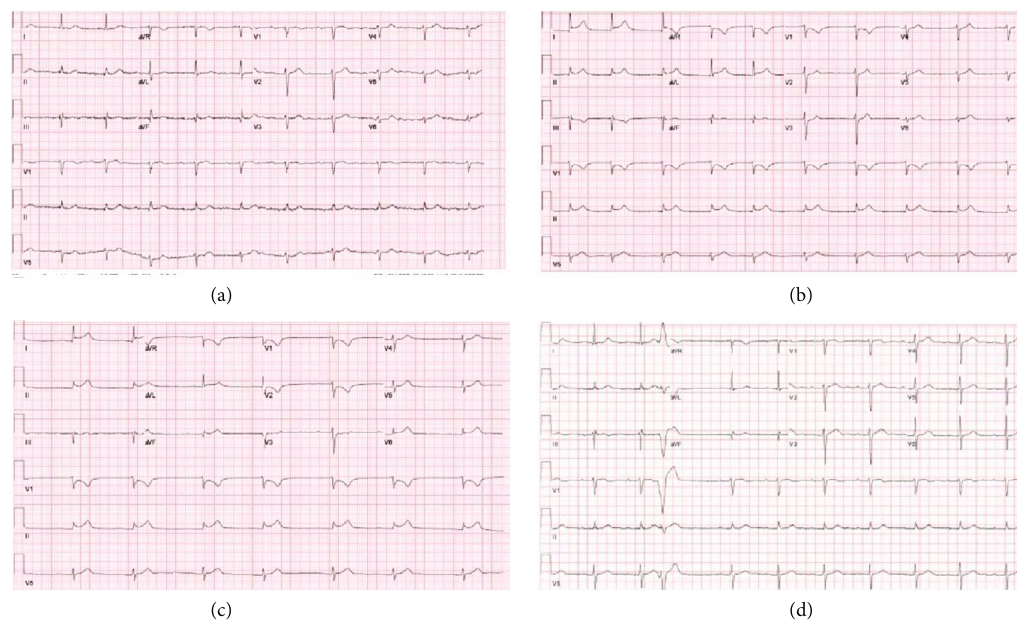
Figure 1: (a) Baseline ECG notable for 1 st degree AV block and poor R wave progression that was comparable to the patient ’ s prior ECGs. (b) ECG on hospital day 2 showing the interval development of a junctional rhythm along with minor ST segment elevation in leads I, II, and aVL. (c) ECG 36 hours after admission showing persistence of the junctional rhythm along with ST segment elevation in leads I, II, III, aVL, aVF, and V6 along with ST segment depression in leads V1 and V2. This ECG prompted a code STEMI to be activated. (d) ECG after recovery showing a return to normal sinus rhythm with persistence of the 1 st degree AV block and a return of the ST segments to their original baseline.